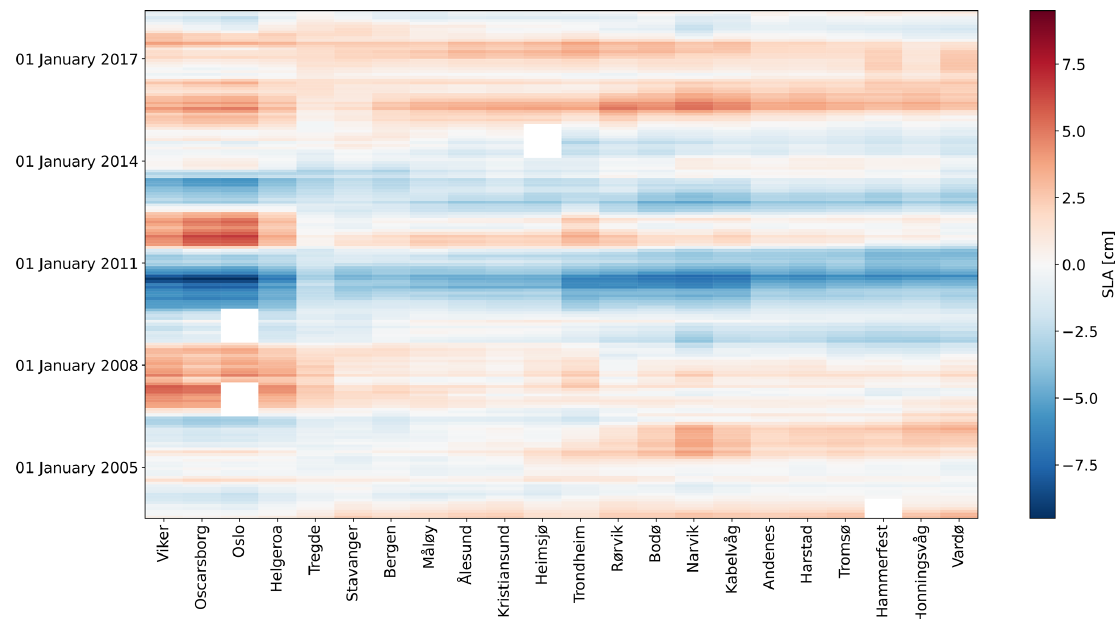
Figure 4. Hovmöller diagram of the detrended and deseasoned monthly mean SLA from tide gauges. The SLA at each tide gauge has been low-pass-filtered with a 1-year running mean. The tide gauges are displayed on the x axis. Time is displayed on the y axis and increases from bottom to top.